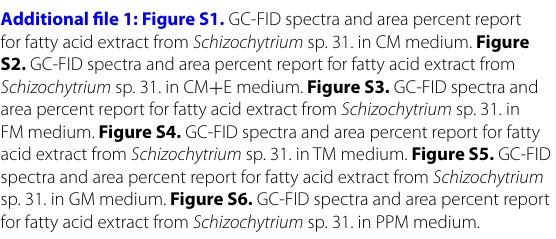
Additional file 1: Figure S1. GC-FID spectra and area percent report for fatty acid extract from Schizochytrium sp. 31. in CM medium. Figure S2. GC-FID spectra and area percent report for fatty acid extract from Schizochytrium sp. 31. in CM E medium. Figure S3. GC-FID spectra and + area percent report for fatty acid extract from Schizochytrium sp. 31. in FM medium. Figure S4. GC-FID spectra and area percent report for fatty acid extract from Schizochytrium sp. 31. in TM medium. Figure S5. GC-FID spectra and area percent report for fatty acid extract from Schizochytrium sp. 31. in GM medium. Figure S6. GC-FID spectra and area percent report